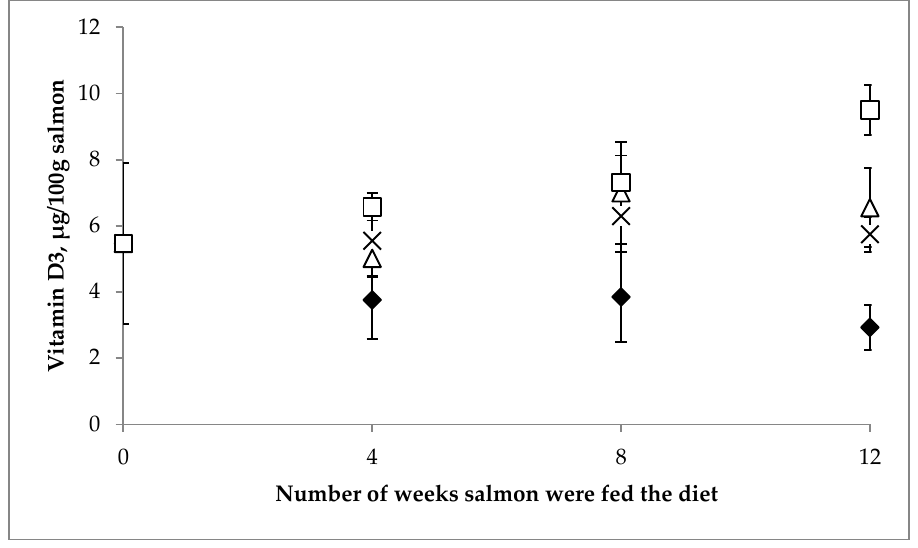
Figure 3. Mean vitamin D 3 (µg/100 g) in fillet of farmed Salmo salar ( n = 5) at baseline, week 4, week 8 and week 12, in the four feeding groups receiving vitamin D, at the dietary level of 270 µg/kg ( ♦ ), 590 µg/kg (x), 890 μg/kg (Δ) and 1440 μg/kg (□). Error bars representing the SD around the means.